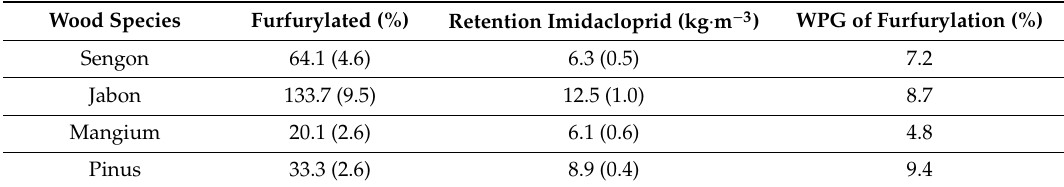
Table 8. Weight percent gain (WPG) and retention values of the samples (Numbers in parentheses are standard